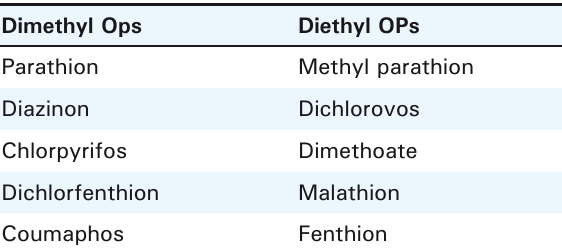
Table 1. Common dimethyl and diethyl phosphoryl